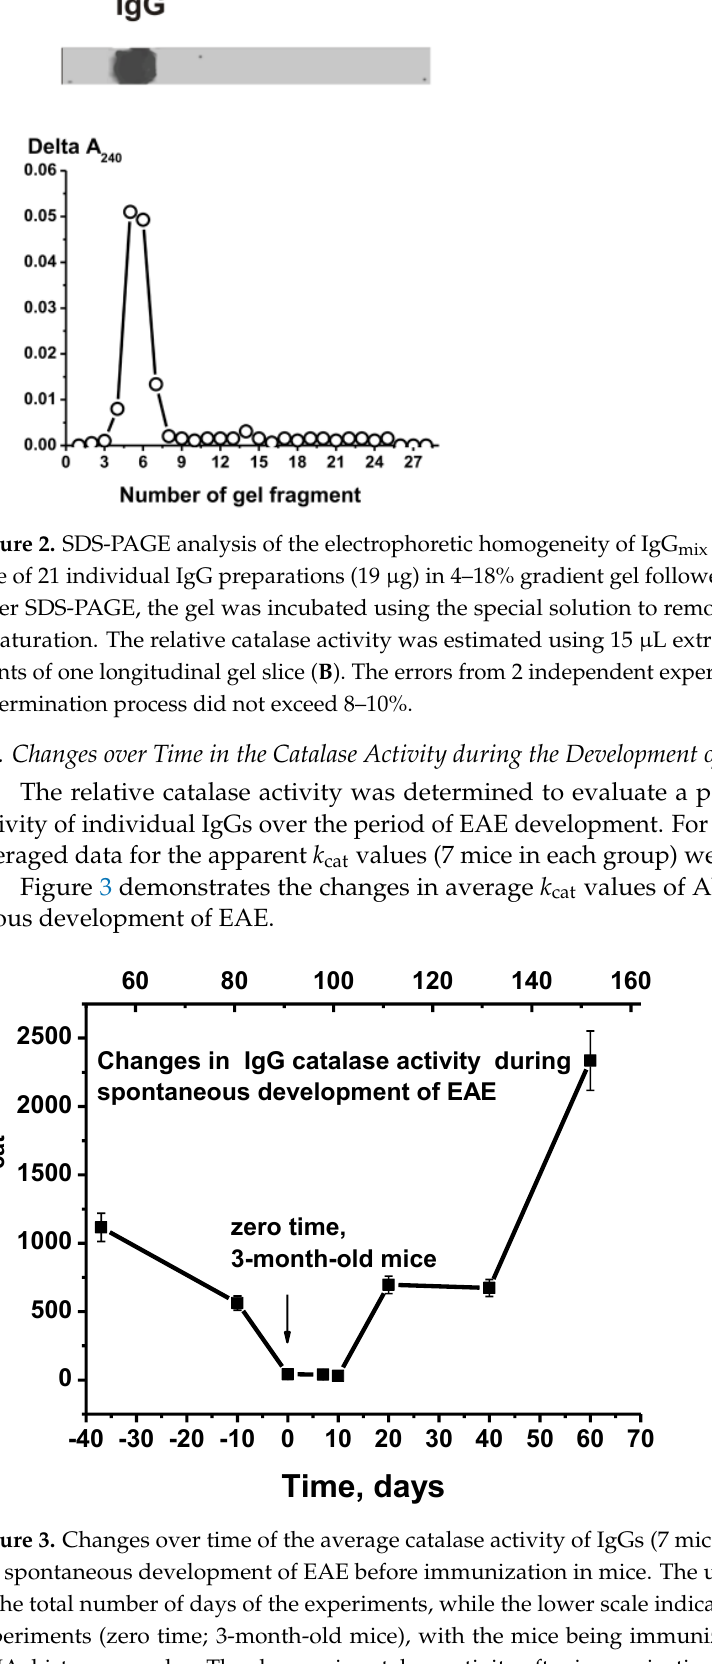
Figure 3. Changes over time of the average catalase activity of IgGs (7 mice in each group) during the spontaneous development of EAE before immunization in mice. The upper scale corresponds to the total number of days of the experiments, while the lower scale indicates the beginning of the experiments (zero time; 3-month-old mice), with the mice being immunized with MOG and the DNA – histone complex. The changes in catalase activity after immunization are shown in Figure 4.